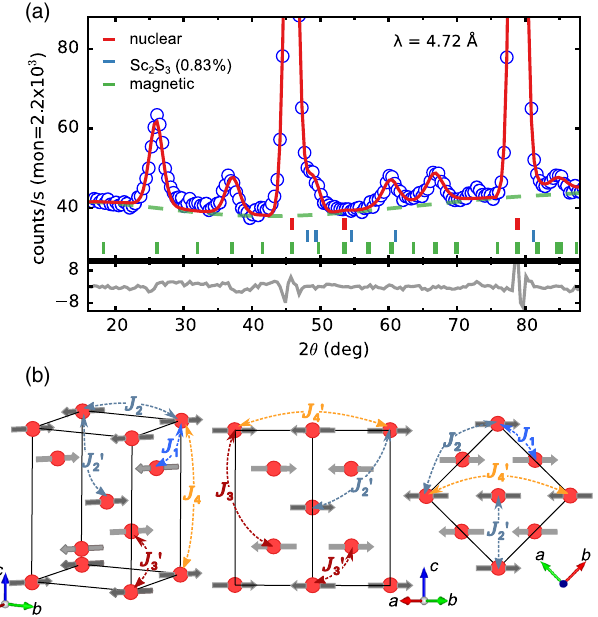
FIG. 5. (a) Neutron powder diffraction collected on MACS at 1.6 K. Open symbols are observed intensities, solid line is the calculated intensity for the magnetic structure shown in (b), and dashed green line is background. (b) Proposed magnetic structure of FeSc 2 S 4 shown in perspective view and projected along the ð 110 Þ , and ð 001 Þ directions of the tetragonal cell. Identical t t moments on crystallographically distinct Fe sites are drawn in light and dark gray to highlight the two CT sublattices.